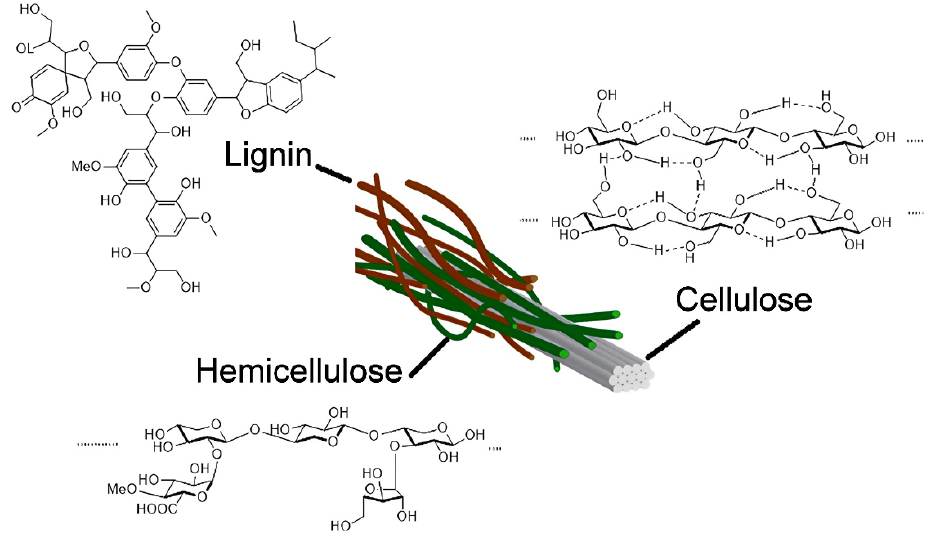
Figure 1. Cellulose, hemicellulose, and lignin contained inside biomass. Reproduced with permission from [14].